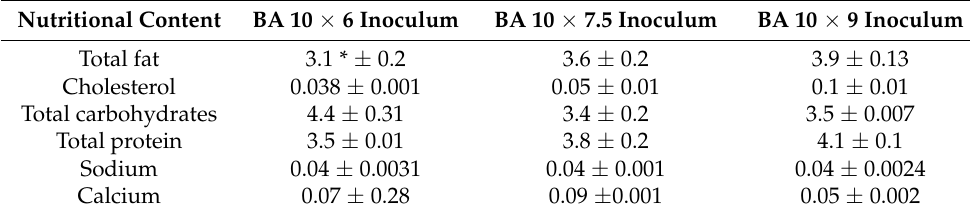
Table 2. Nutritional content of BEY (~100 mL) in comparison with commercial